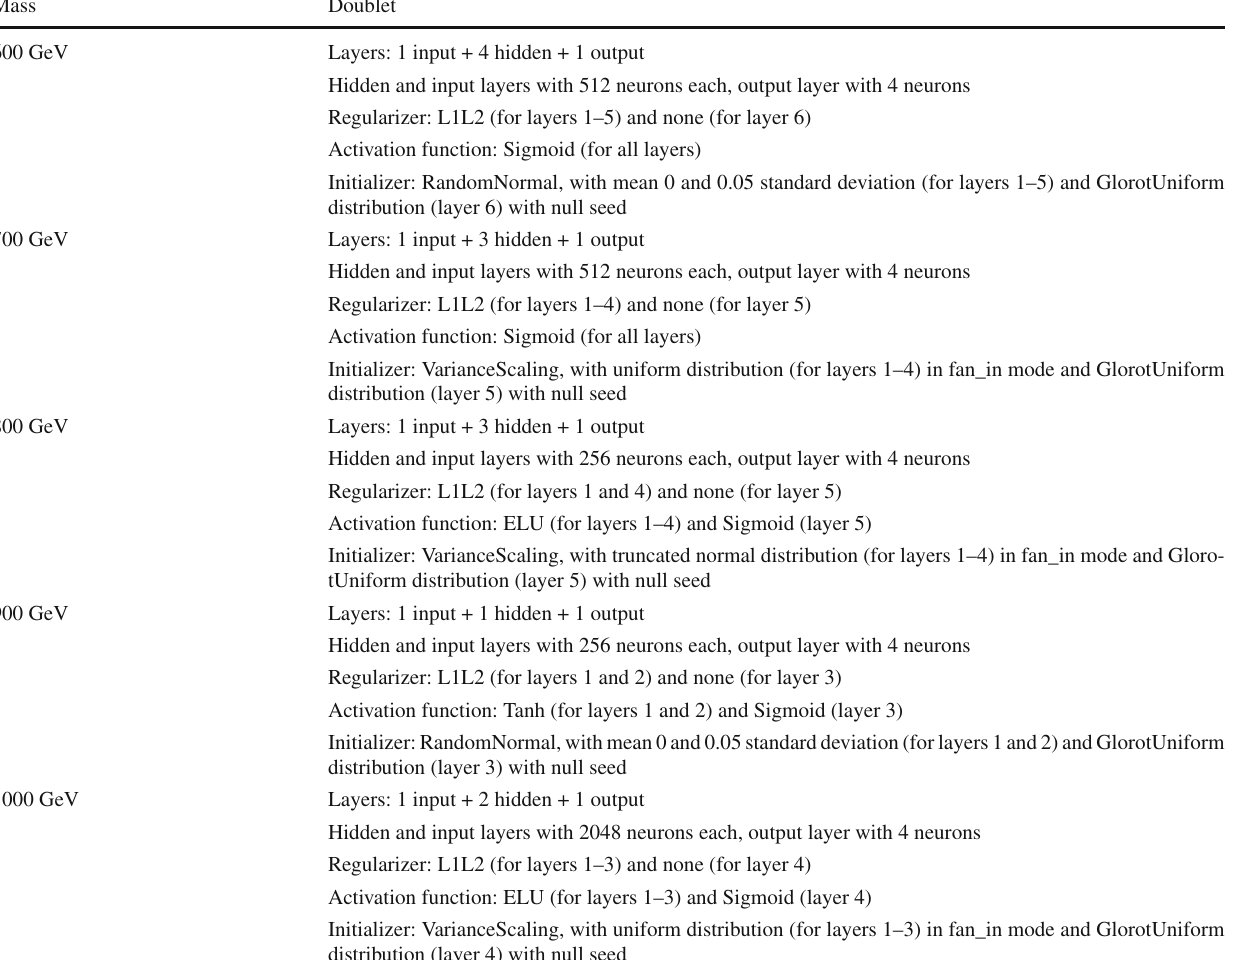
Table 9 Architectures for the neural networks that the genetic algorithm finds for the scanned masses (600–1000 GeV) of the doublet VLL scenario Mass Doublet 600 GeV